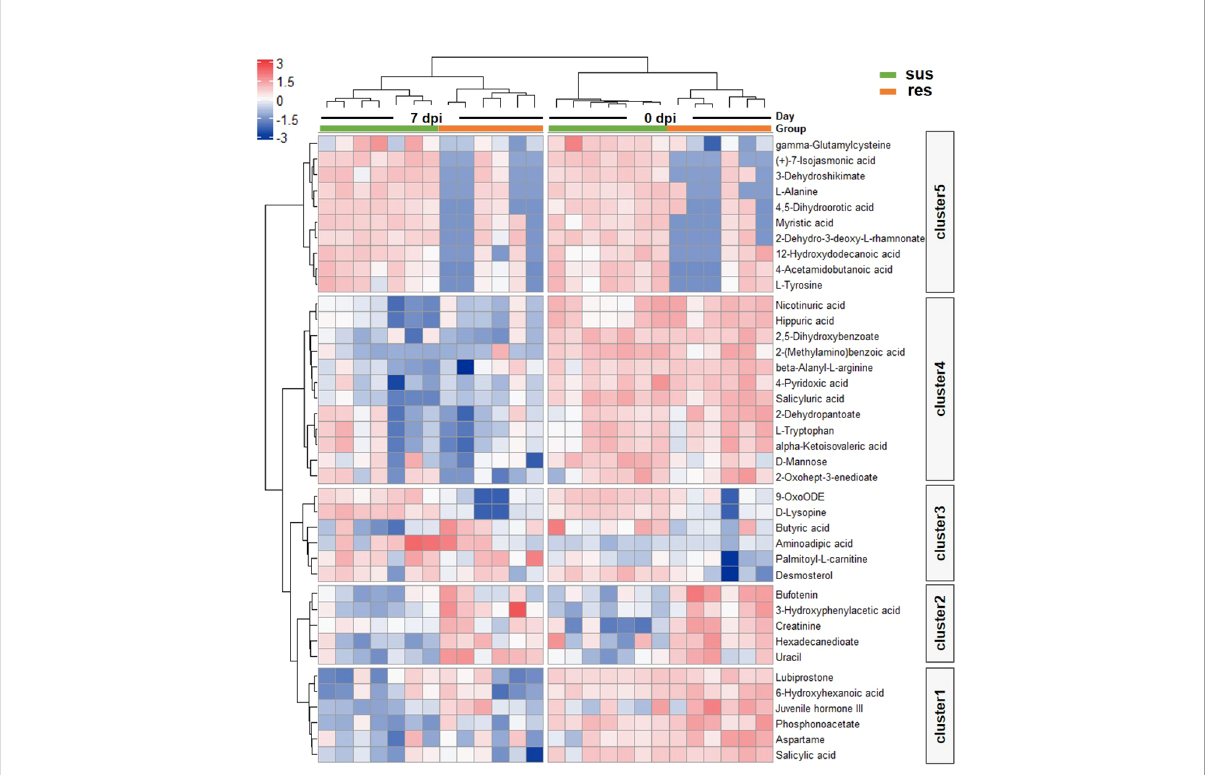
FIGURE 6 Heatmap of DE metabolites by one way ANOVA. Blue to red scale indicates negative or positive associations based on metabolites expression levels. Each column represents a sample, and each row represents a DE